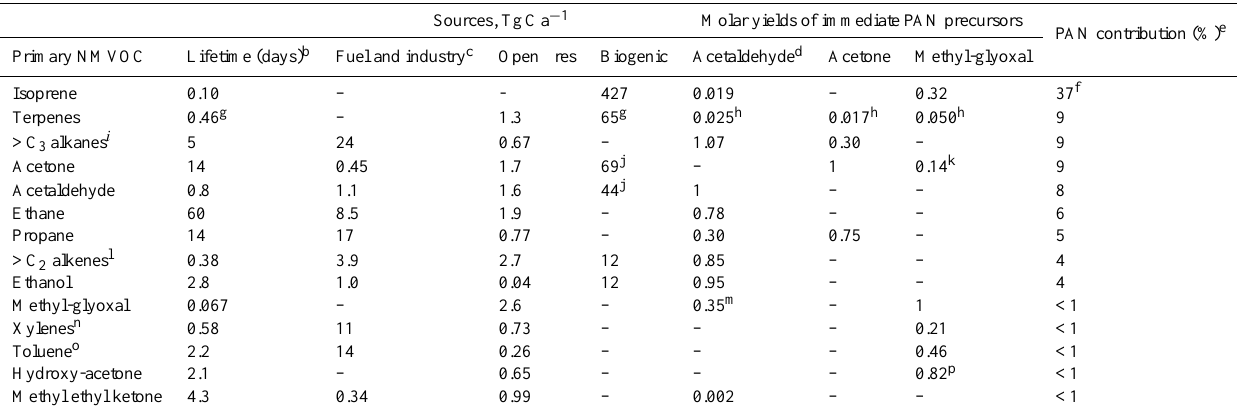
Table 1. Global contributions of primary NMVOCs to PAN formation a